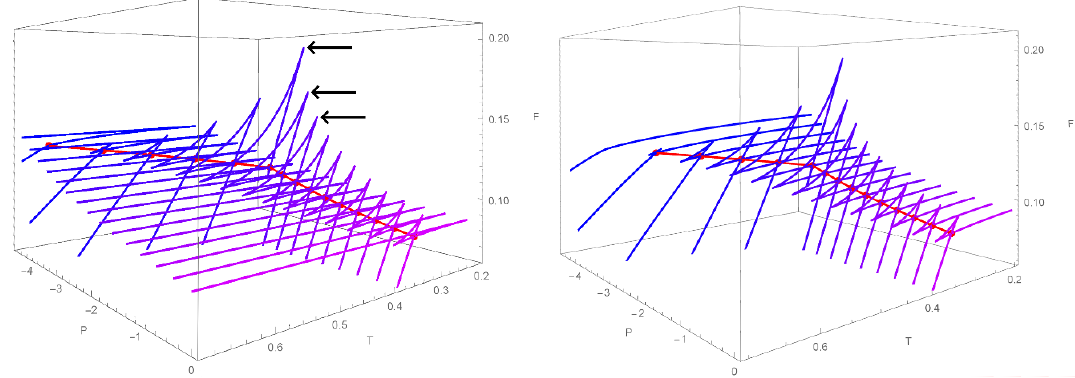
Figure 7 . Helmholtz free energy of the Born-Infeld-de Sitter black hole for q = 0 : 105, r c = 0 : 6, showing slices of (cid:12)xed P . The red dots mark the small ! large phase transition on each slice. The red line is the coexistence curve. Left : b = 4 : 6. A reentrant phase transition is present on the slices indicated with the black arrows. These slices resemble (cid:12)gure 6a. The remaining slices resemble (cid:12)gure 6b. Right : b = 5. There are no reentrant phase transitions present. Note the di(cid:11)erence in small- T behaviour between the two (cid:12)gures: on the left, there is a minimum temperature at which the black hole phase exists, while on the right there is no minimum temperature (the lines extend to T =